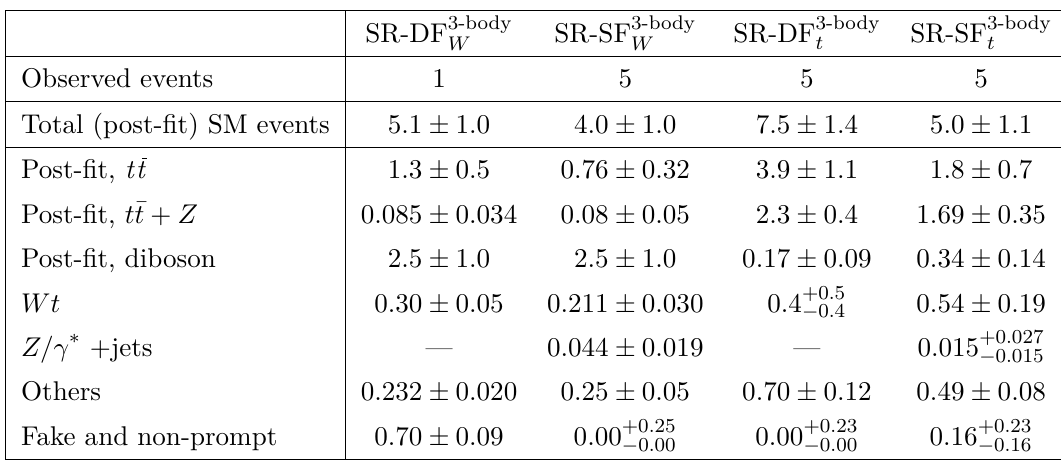
Table 17 . Three-body selection. Observed event yields and background fit results for the three- body selection SRs. The ‘Others’ category contains contributions from V V V , tt t , tttt , tt W , tt WW , tt WZ , tt H , and tZ . Combined statistical and systematic uncertainties are given. Entries marked ‘–’ indicate a negligible background contribution (less than 0.001 events). The individual uncertainties can be correlated, and do not necessarily add up in quadrature to the total background uncertainty.